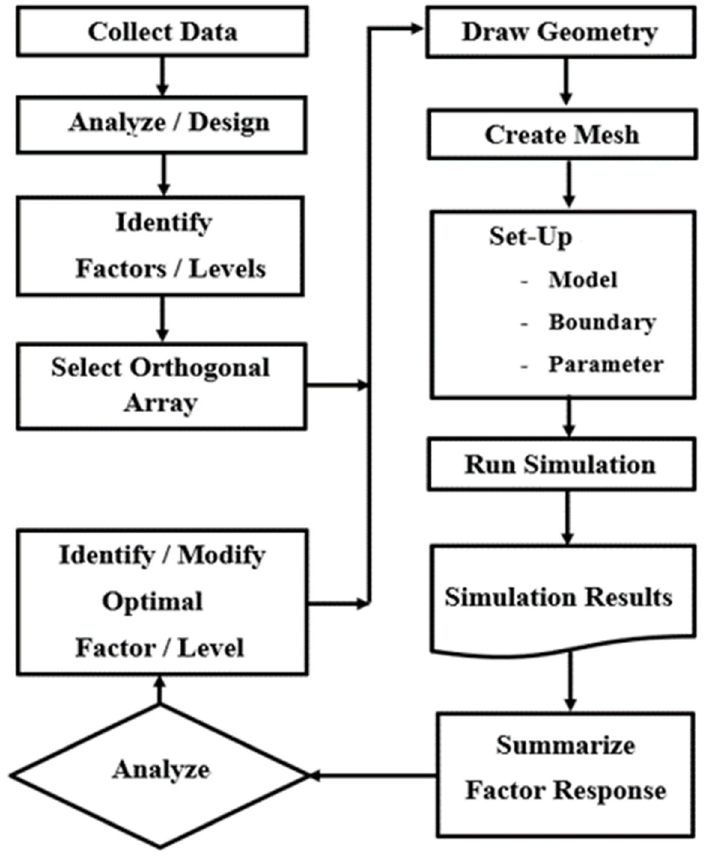
Figure 2. Diagram of modeling process flow.